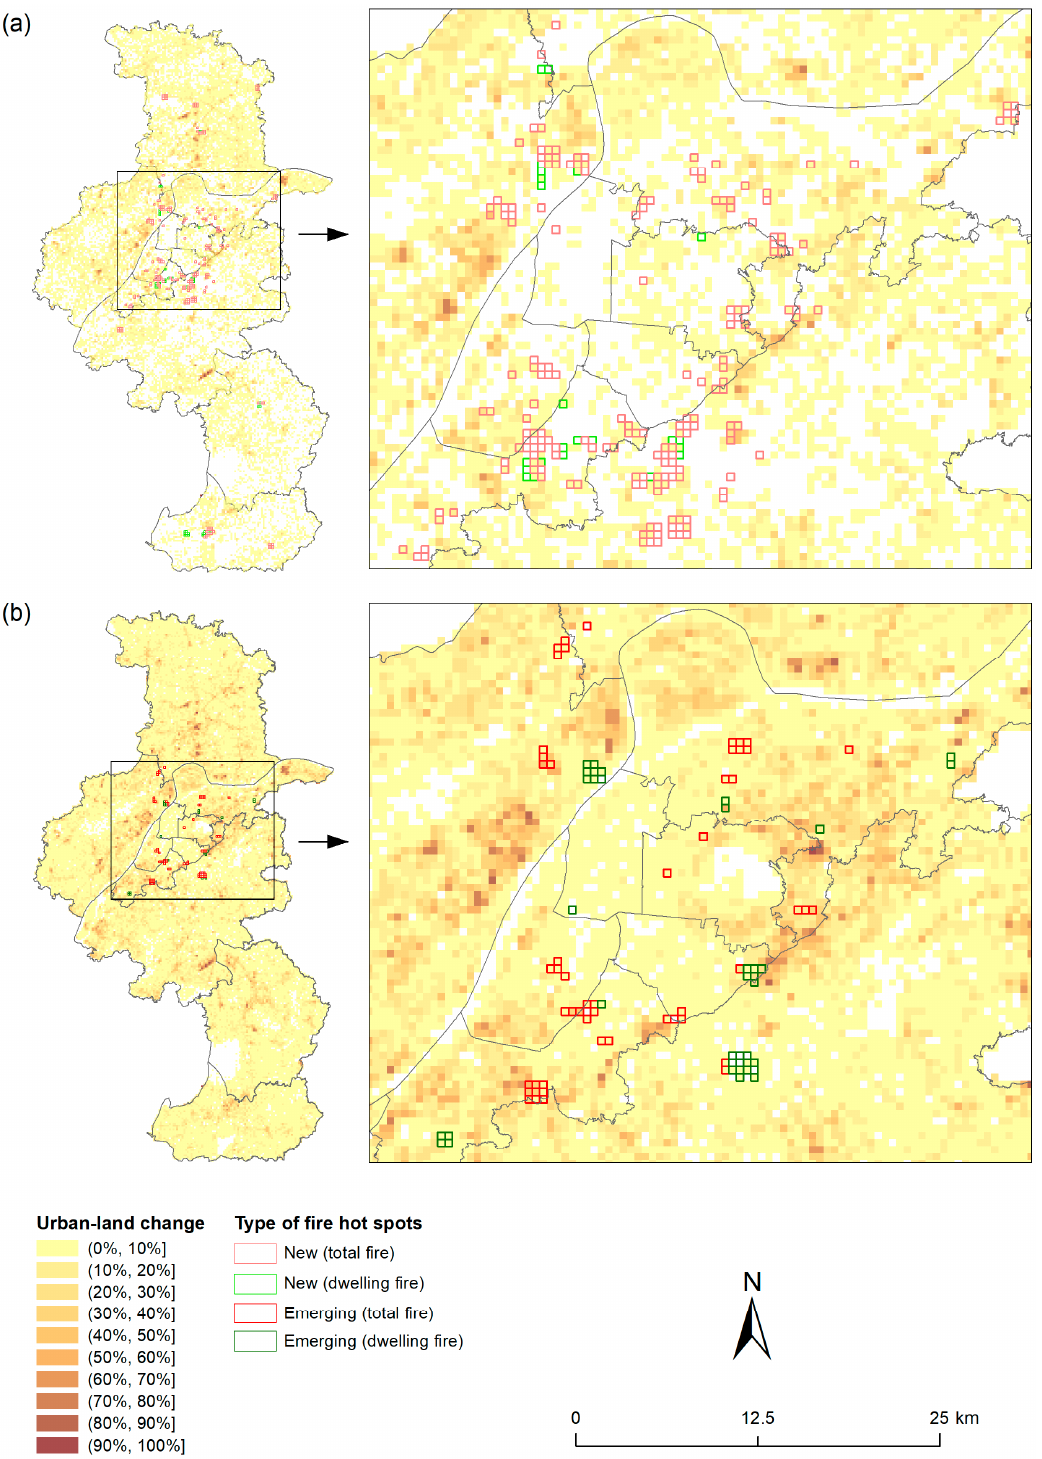
Figure 11. Comparison of urban fire hot spots and urban land changes: ( a ) “new” hot spots vs. urban land change in 2010-2013 and ( b ) “emerging” hot spots vs. urban land change in 2008–2013.